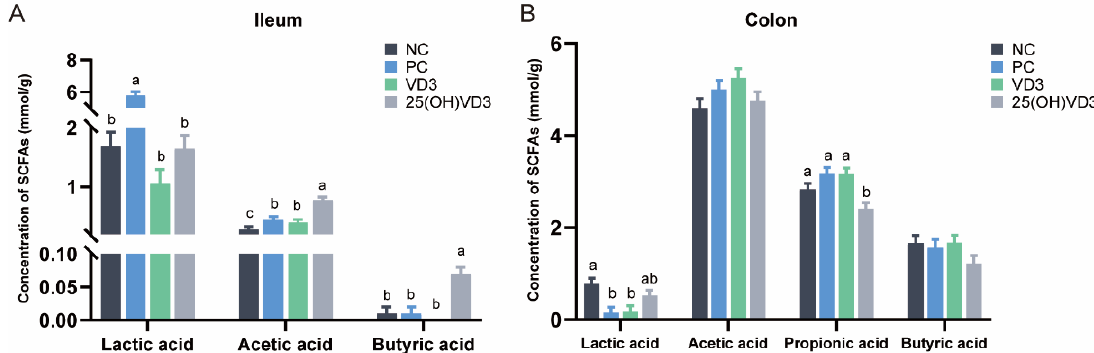
Figure 6. The concentration of SCFAs in the intestinal digesta of weaned piglets. ( A ): The concen- tration of SCFAs in the ileum. ( B ): The concentration of SCFAs in the colon. Note: Different letters on the top of the column indicate significant differences ( p < 0.05), n = 6. NC, negative control; PC, positive control; VD3, vitamin D 3 ; 25(OH)VD3, 25-hydroxyvitamin D 3 .